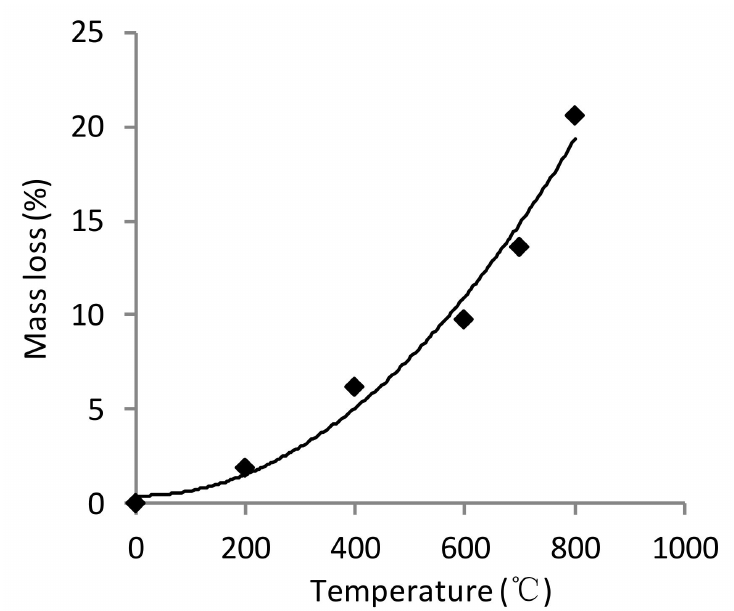
Figure 3. WCP mass losses with the thermal treatment.